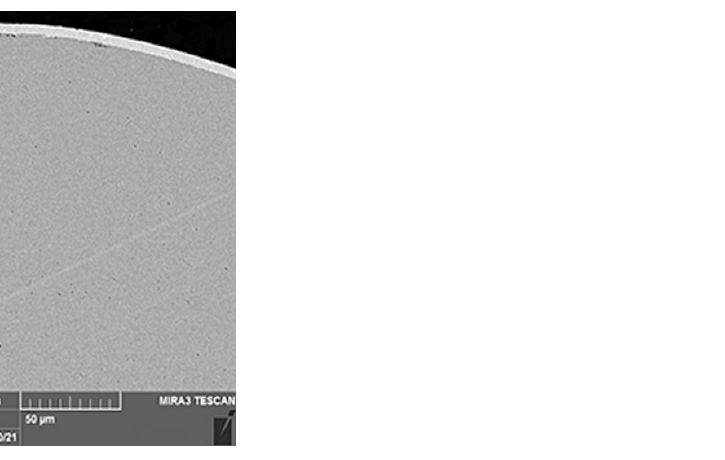
Figure 3. SEM image of the microstructure of composite Ni-LaF 3 coatings on the surface of the wire. Sulfur hexafluoride SF 6 : SF 6 > 99.9%, H 2 O < 5 ppm, CF 4 < 500 ppm, air < 500 ppm (Linde AG, Pullach, Germany) was introduced into pure argon through a WITT KM gas